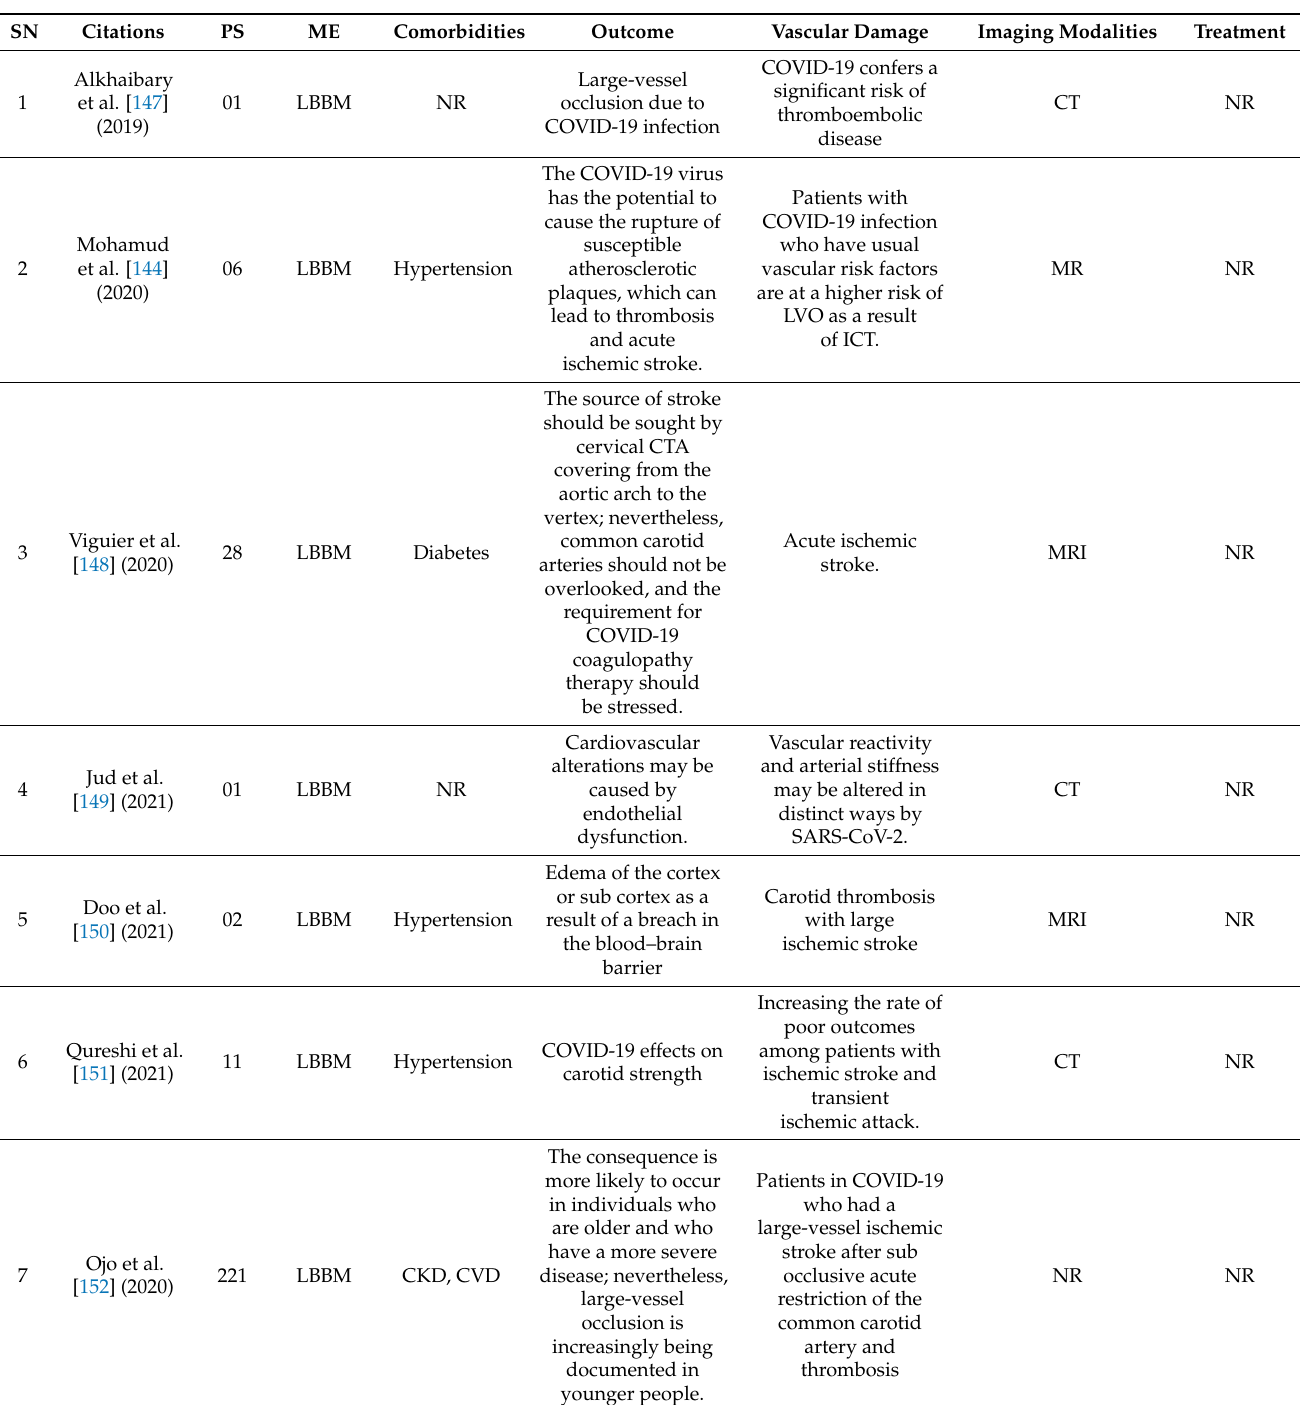
Table 4. Effect of COVID-19 on carotid vascular